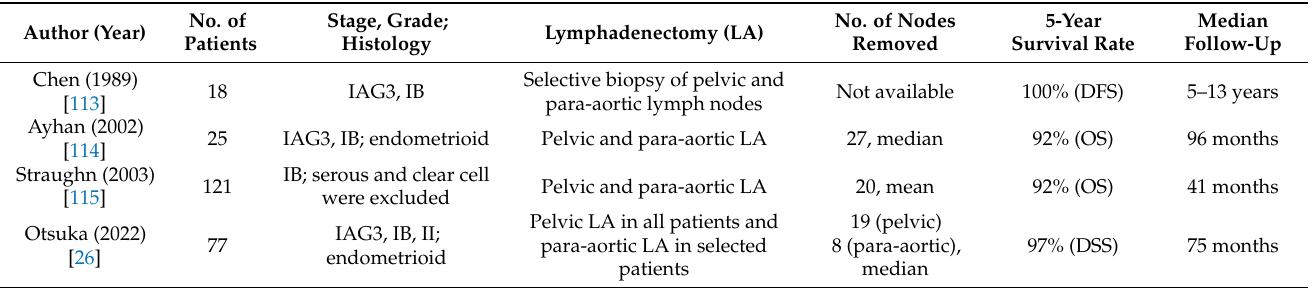
Table 2. Long-term outcomes of patients with intermediate- and high-risk endometrial carcinoma treated with open surgery alone, including pelvic and para-aortic